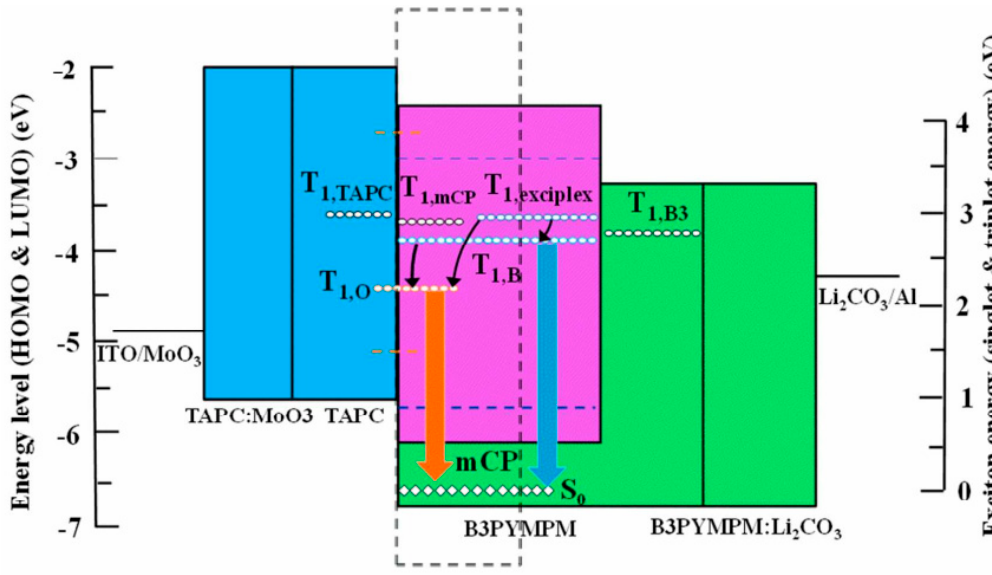
Figure 8. Device structure and energy levels. Black dashed rectangle is the main exciton recombination zone. O, B, and B3 are PO-01, FIrpic, and B3PYMPM, respectively. Solid and dashed lines correspond to the highest occupied molecular orbital (HOMO) and lowest unoccupied molecular orbital (LUMO) energy levels. Circles and diamonds are T 1 and S 0 exciton energies, respectively [181].